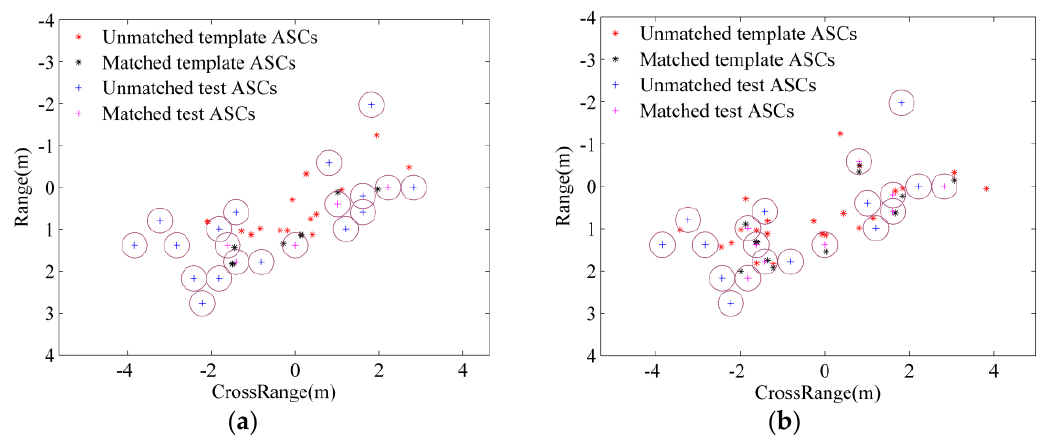
Figure 5. The neighbor matching results between the BMP2 test ASC set and the template ASC sets from other targets: ( a ) T72; ( b ) BTR70.